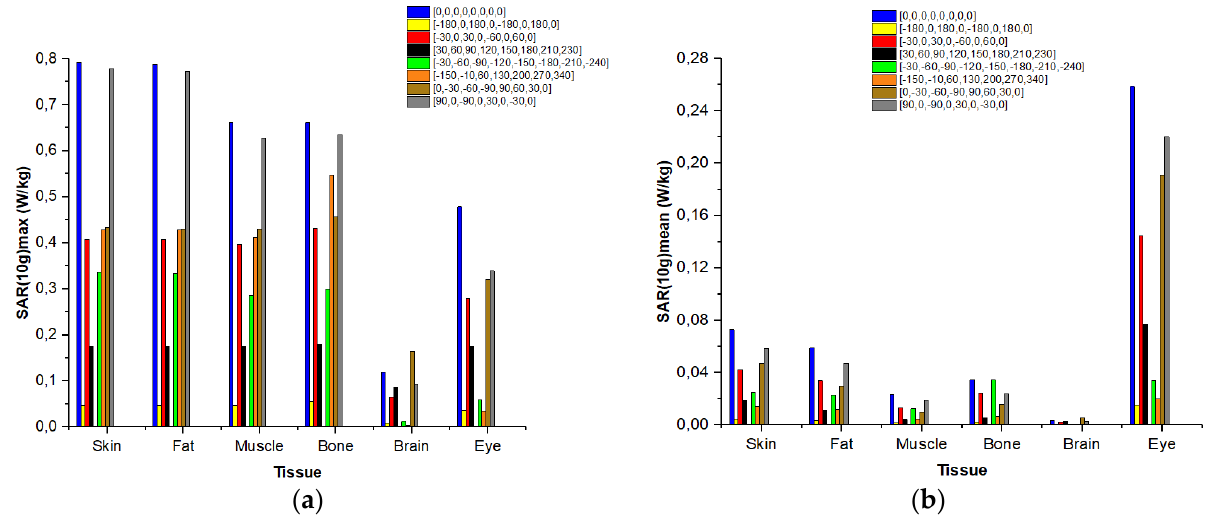
Figure 8. ( a) SAR max (W/kg) and ( b ) SAR mean (W/kg) inside tissues models according to phase shifts between the elements of the planar 2 × 4 array antenna.